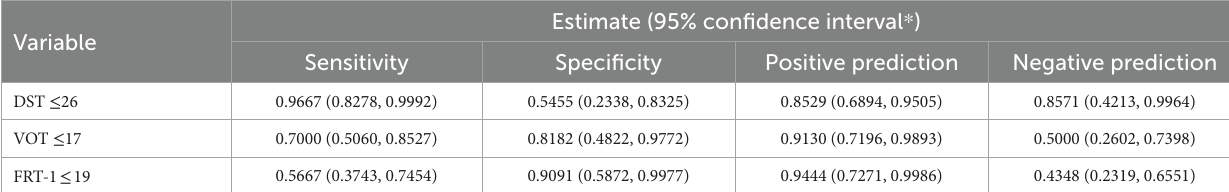
TABLE 3 Sensitivity, specificity, and predictions of DST, VOT, and FRT-1 for visuospatial disorder.